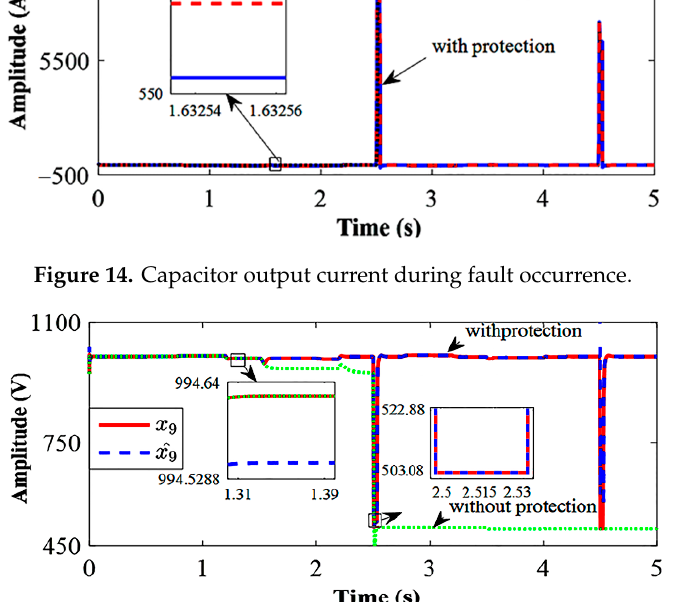
Figure 15. Load bus voltage of C 9 capacitor during fault occurrence.